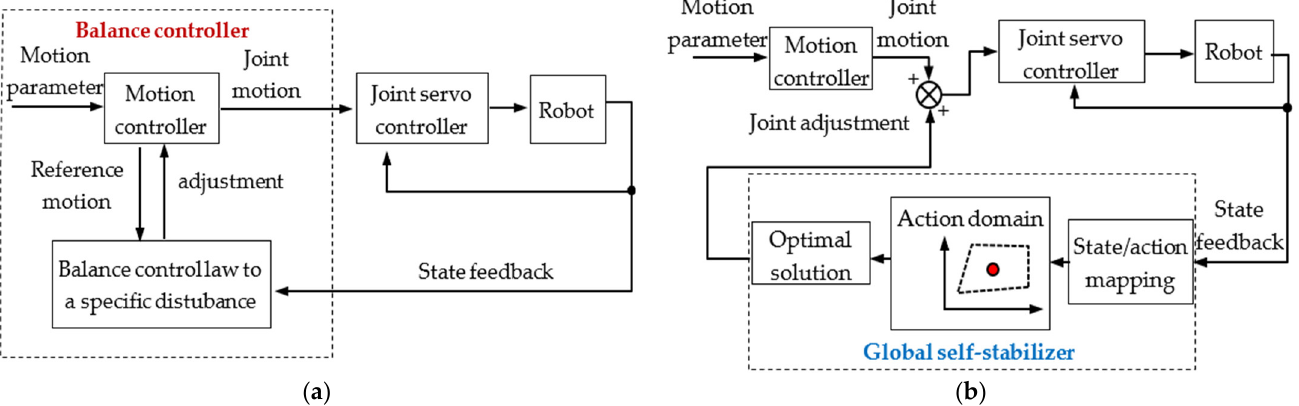
Figure 1. Comparison of a general balance controller and the global self-stabilizer for legged robots. ( a ) General balance controller; ( b ) global self-stabilizer.